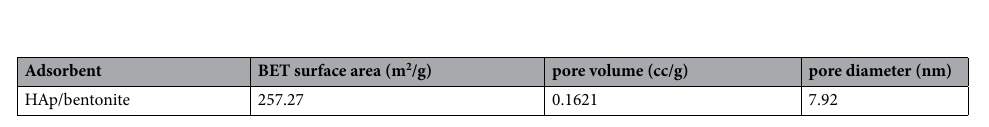
Table 2. Textural properties of prepared HAp/bentonite adsorbent.